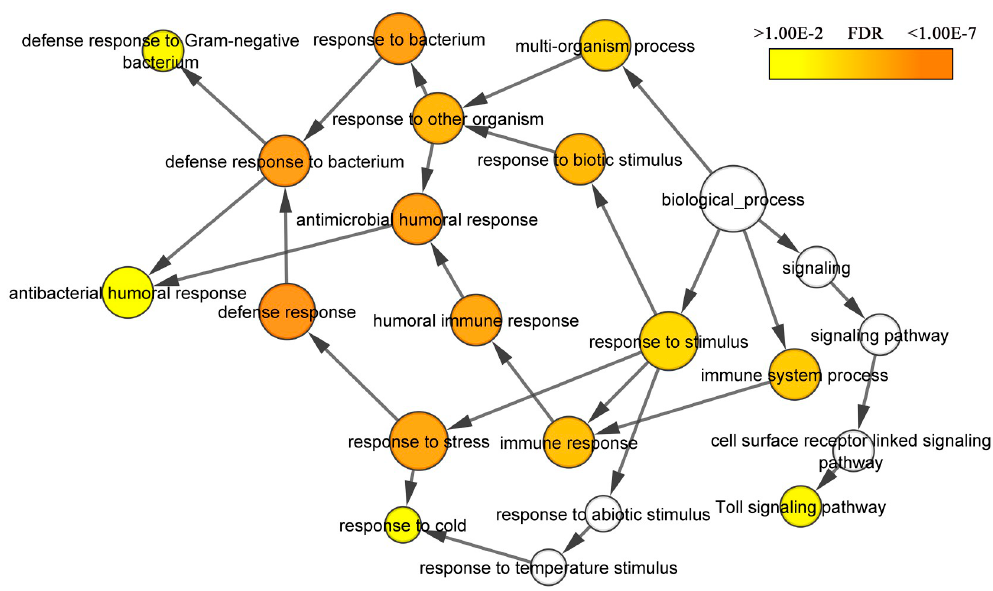
Fig 2. Gene ontology biological process term enrichment analysis for up-regulated LB-flies genes.